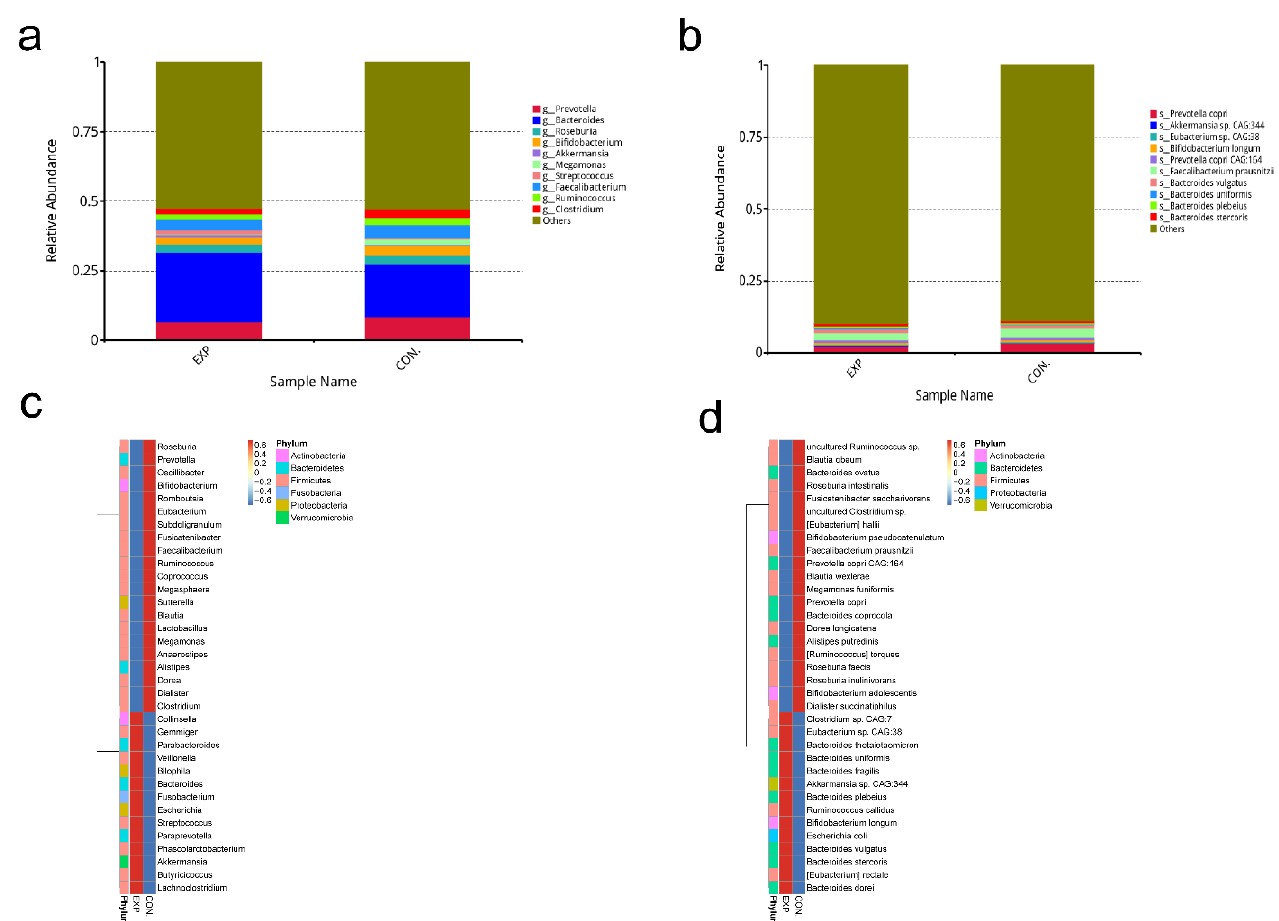
Figure 2. Relative abundance analysis of gut microbiota (BLCA patients, EXP group; healthy individuals, CON group). ( a ) At the genus level, the top 10 microbiomes with maximum relative abundance in two groups are shown. ( b ) At the species level, the top 10 microbiomes with maximum relative abundance in the two groups are shown. The number in non-overlapping circles represents the number of genes unique to the group. ( c ) Heat map of the top 35 microbiomes of abundance ranking in the two groups at genus level. ( d ) Heat map of the top 35 microbiomes of abundance ranking in the two groups at the species level.